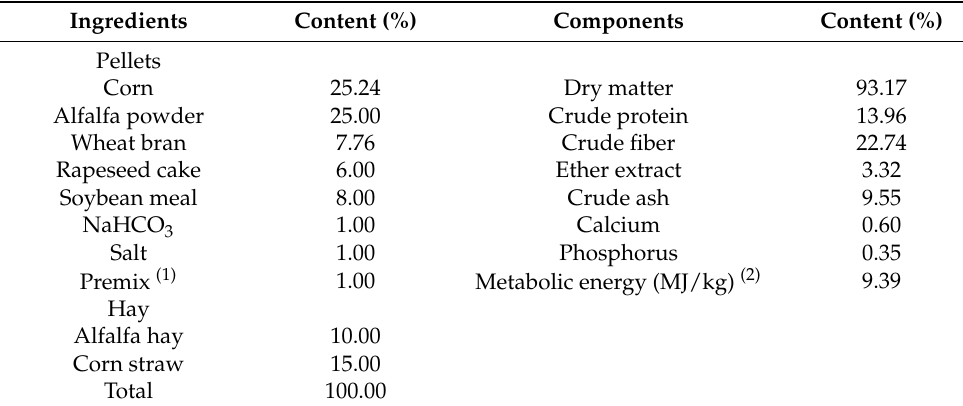
Table 1. Component of dietary formula and nutritional level (dry-matter